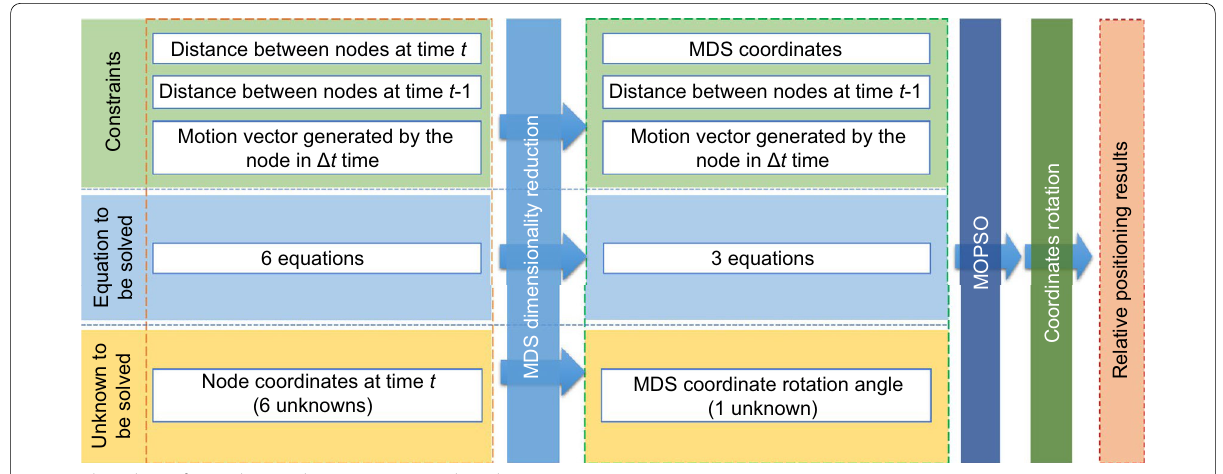
Fig. 3 Flow chart of core cluster relative positioning